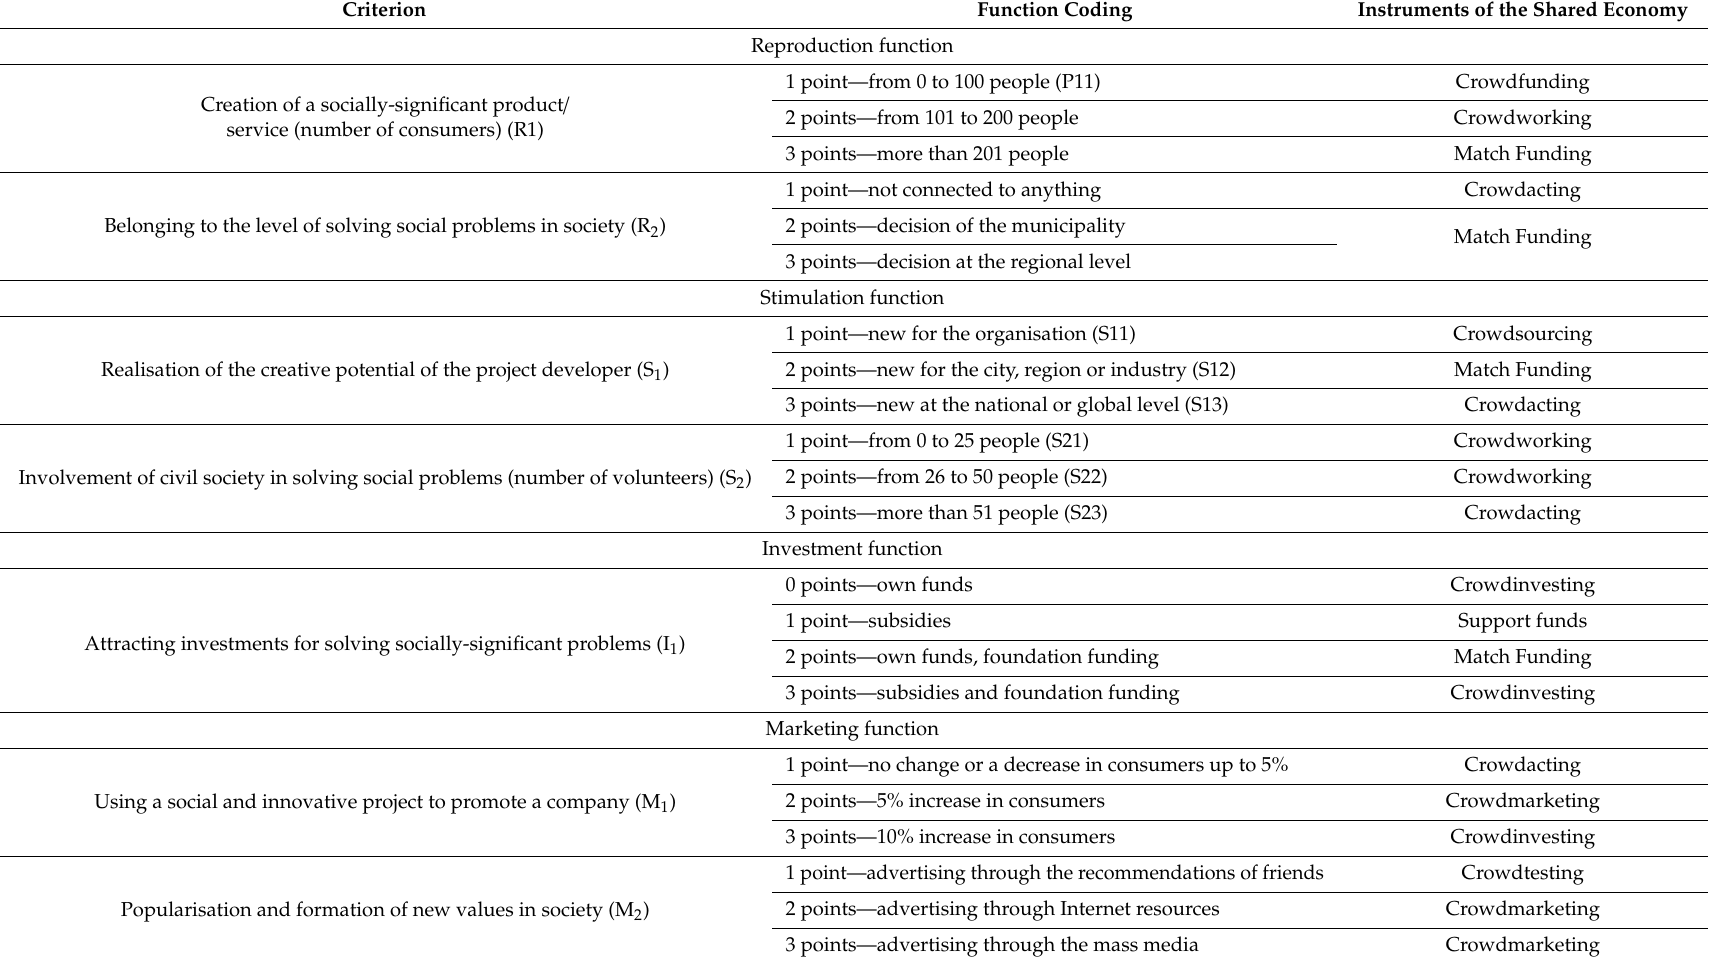
Table 1. Dependence of functions and instruments of the shared